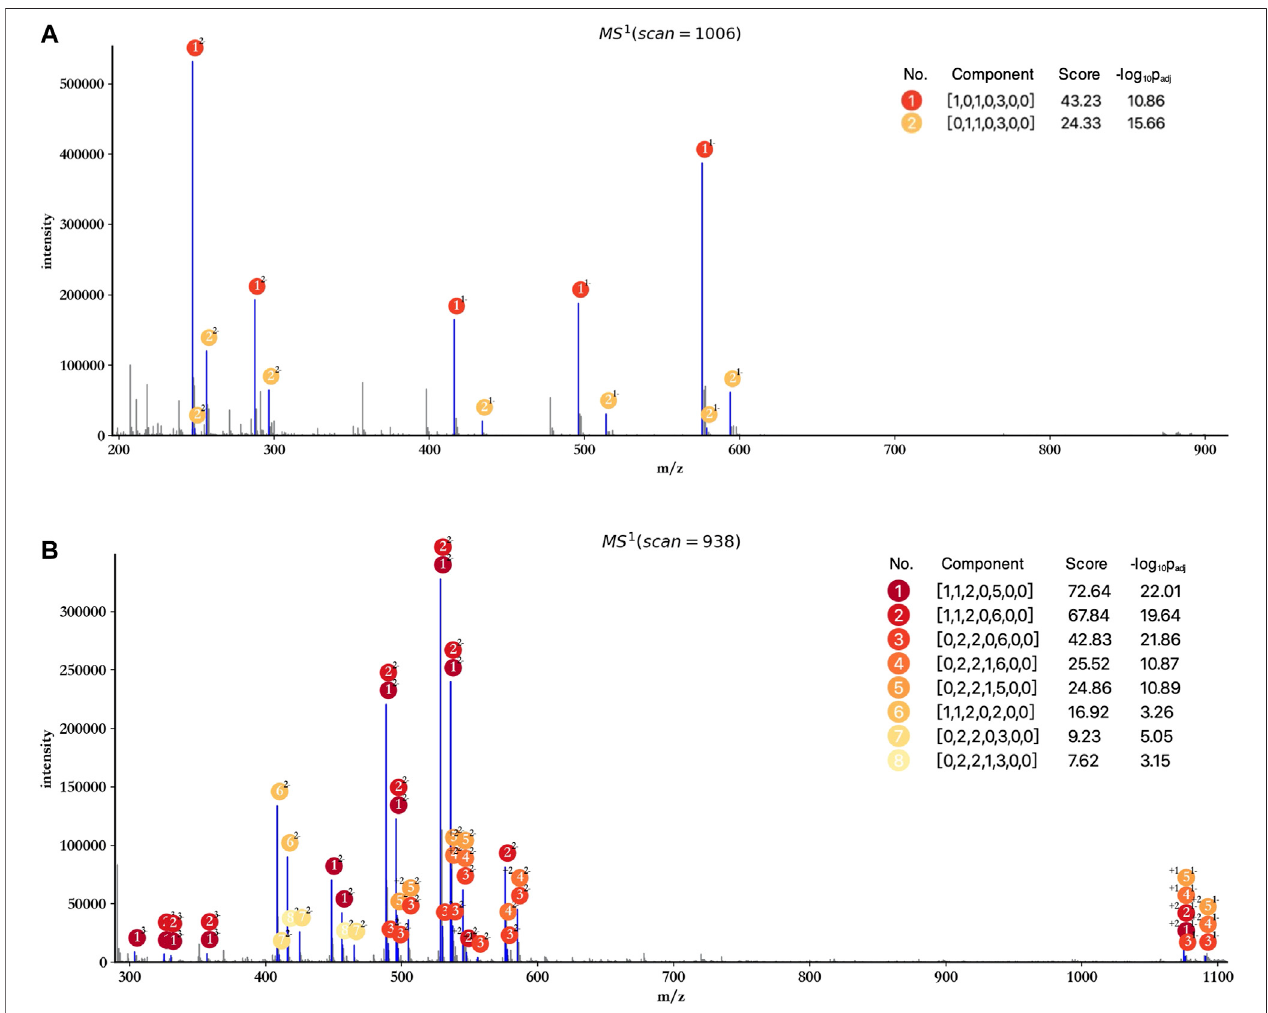
FIGURE3| Pro fi lingresults ofdp2 (A) and dp4 (B) oligosaccharides. The scannumber represents the sampling point order inthe massspectrometry experiment. Each matched isotopic peak cluster in experimental spectraismarked inblue and annotated by thenumber and chargestate of corresponding components. The score of each component is calculated by Eq.1 , which indicates the number and quality of matching peaks for the component.